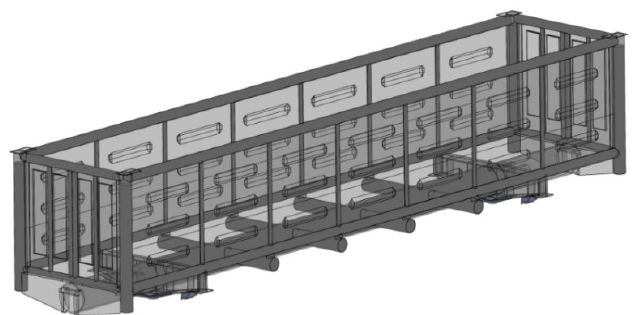
Figure 1. Bearing structure of an open wagon of circular pipes filled with aluminium foam.